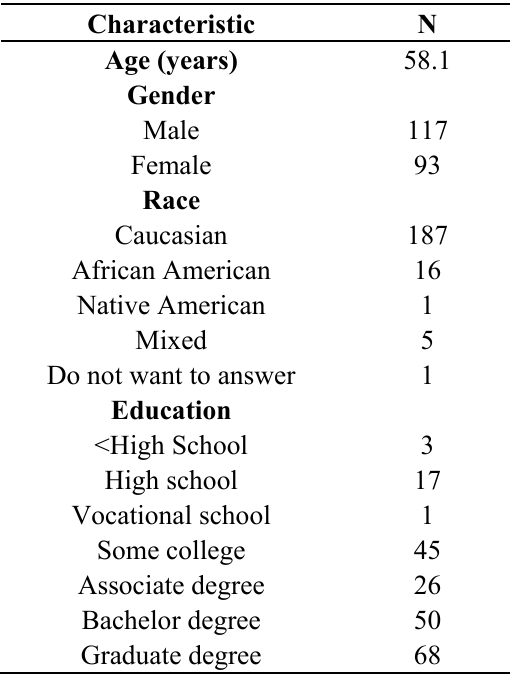
Table 4. Cohort characteristics (n =